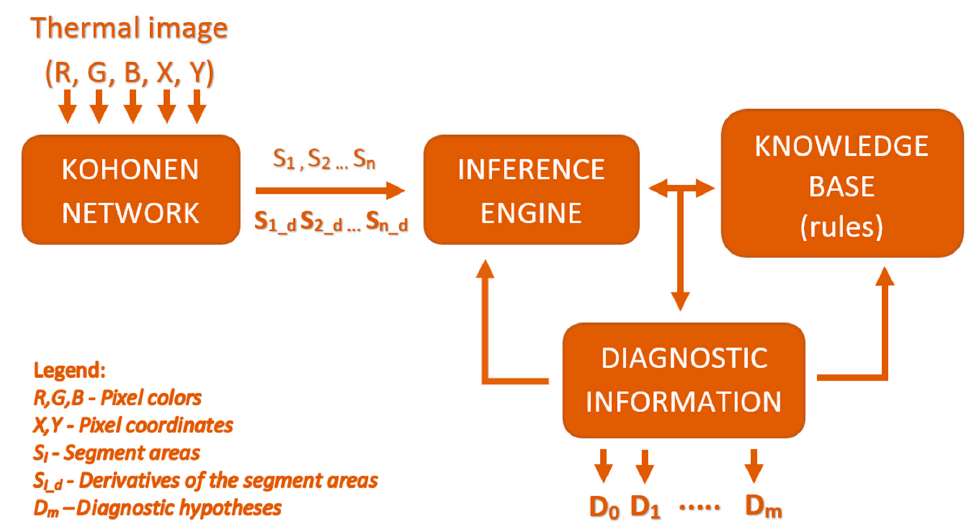
Figure 7. The connection between the Kohonen neural network and an expert system.